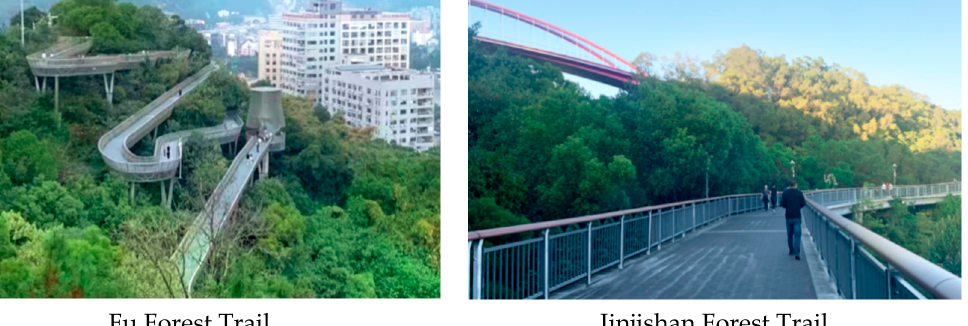
Figure 1. Representative photos of the Fu Forest Trail and Jinjishan Forest Trail.